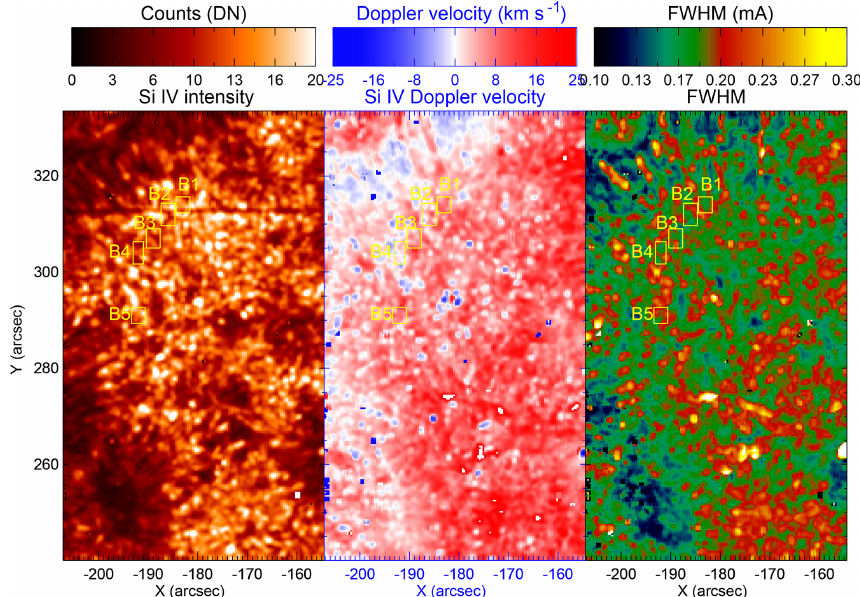
Figure 5. The different parametric plots of SiIV (1393.78Å) line, with the foot points of the quiescent coronal loop systems being indicated by different boxes. DN refers to the data